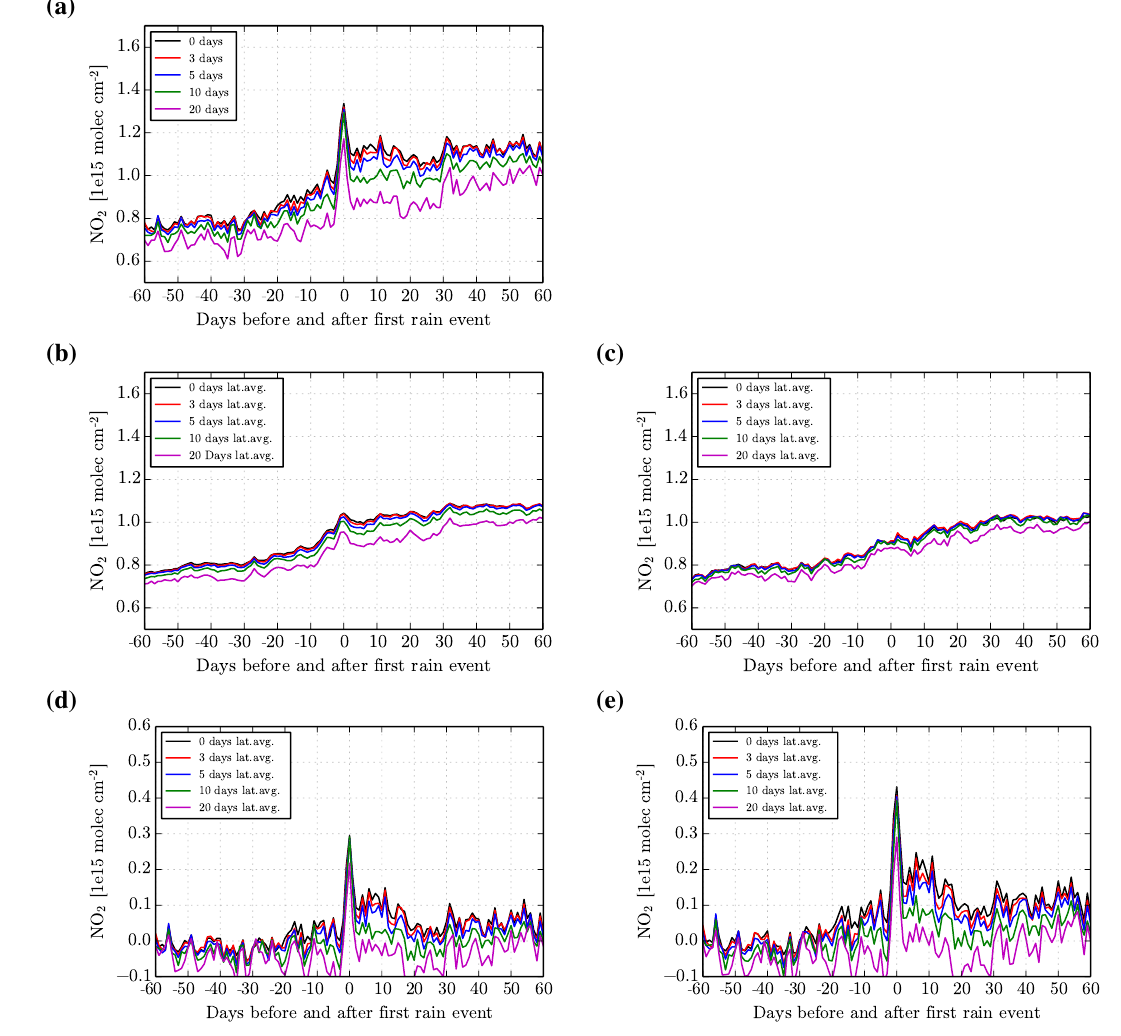
Figure 13. Investigation of the effect of different periods of dry days following Day0. (a) Reference case analysis for OMI NO 2 VCDs filtered for time series experiencing 0, 3, 5, 10 and 20 days of drought after Day0. (b) Background time series of NO 2 VCDs without buffer screening as presented in Fig. 12b for the corresponding time series experiencing 0, 3, 5, 10 and 20 days of drought after Day0. (c) The corresponding background time series of NO 2 VCDs with buffer screening as presented in Fig. 12c. (d) Differences between panels (a, b) . (e) Differences between panels (a, c)